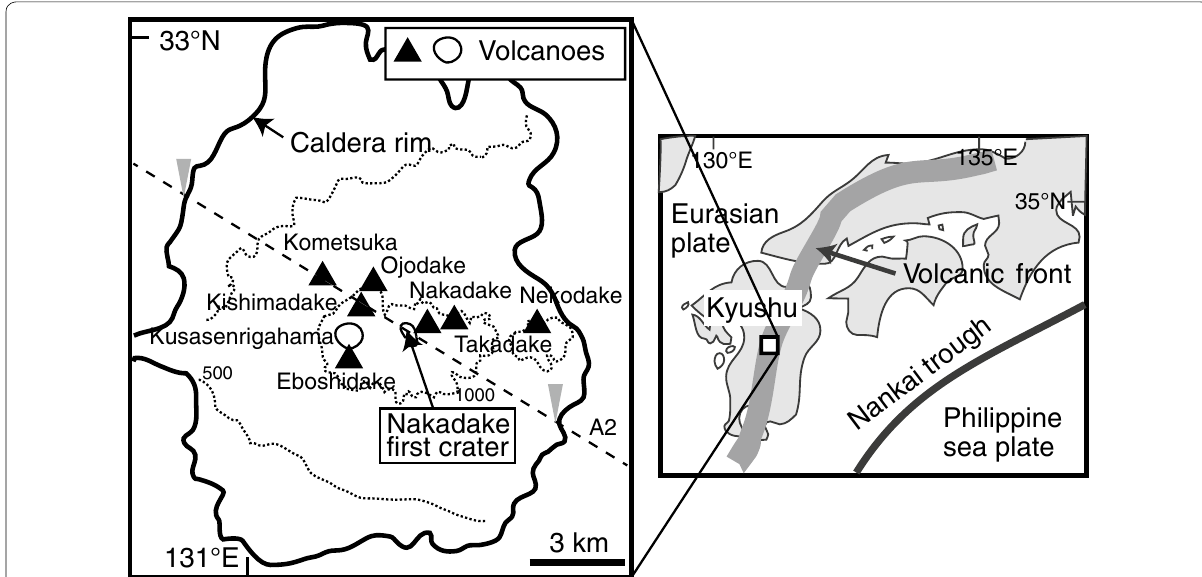
Fig. 1 Maps of the Nakadake and Nakadake first crater, Aso volcano. The right figure shows the location of the Aso volcano in southwest Japan, and the left figure shows the locations of representative post-caldera volcanoes (< 90 ka), except for Nakadake, which formed 150 ka. The dashed black line labeled A2 in the left figure indicates the profile used by Hata et al. (2016) to estimate the cross section of three-dimensional electrical